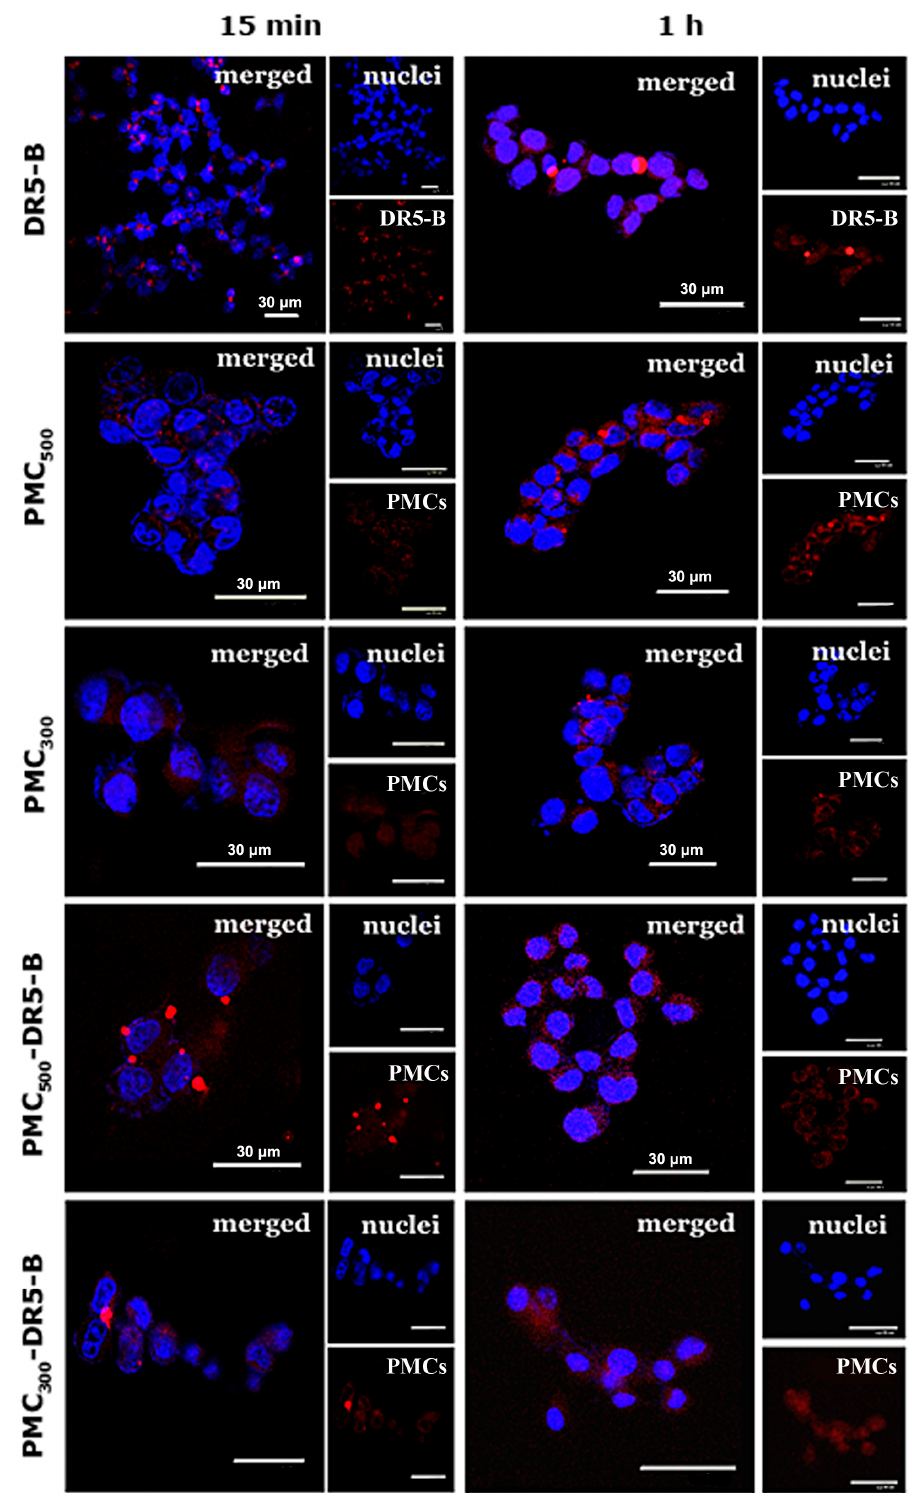
Figure 4. CLSM images of human colorectal carcinoma HCT-116 cells (monolayer cell culture) after 15 min and 1 h incubation with the free DR5-B protein, the unmodified capsule samples (PMC 500 and PMC 300 without DR5-B) as well as with the capsules modified with DR5-B. Free DR5-B (labeled with sulfo-Cyanine3 maleimide), the PMC samples modified with DR5-B (labeled with sulfo-Cyanine3 maleimide) and the unmodified PMC (loaded with R6G rhodamine) are in red. Cell nuclei stained with Hoechst 33258 are in blue. Confocal microscopy. The scale bar is 30 µ